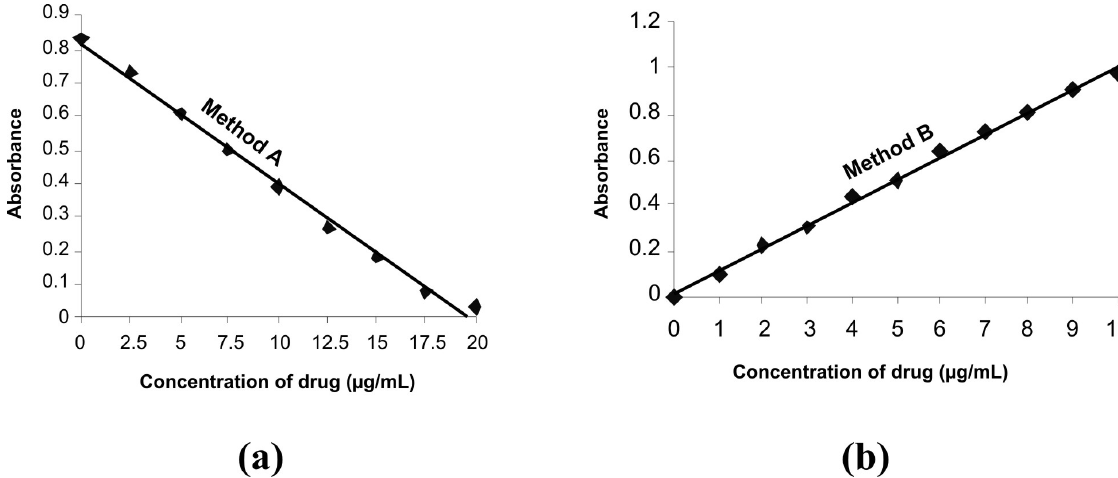
FIGURE 6 - Calibration curves for method A and method